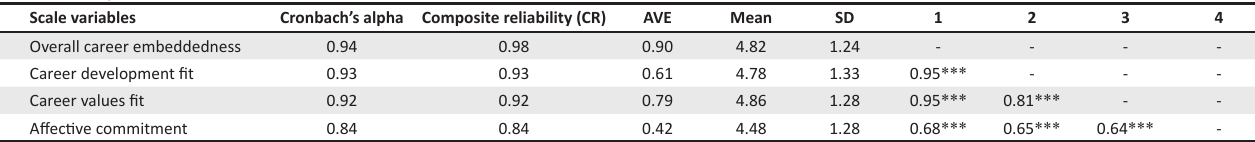
TABLE 1: Descriptive statistics and bivariate correlations. Scale variables